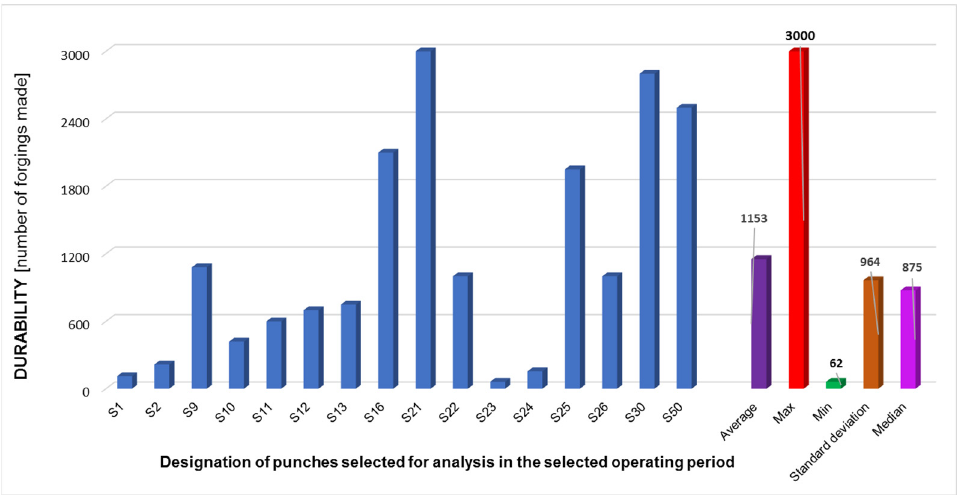
Figure 4. Comparison of the durability of selected punches (S1–S50) used in the second forging operation during the time of 10 months.